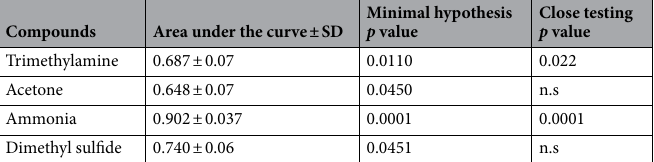
Table 5. Bonferroni-Holm correction. n.s. not significant; SD standard